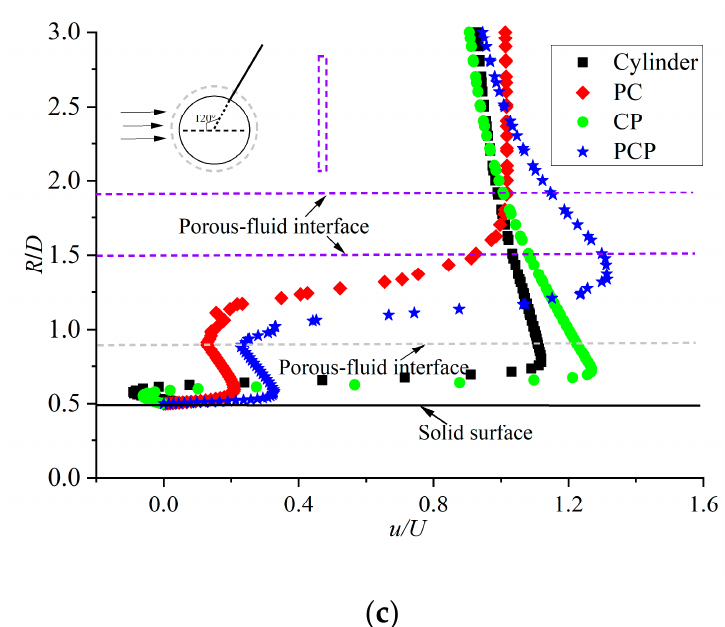
Figure 9. Time-averaged velocity profiles at different circumferential angle: ( a ) θ = 60°, ( b ) θ = 90°, ( c ) θ = 120°.